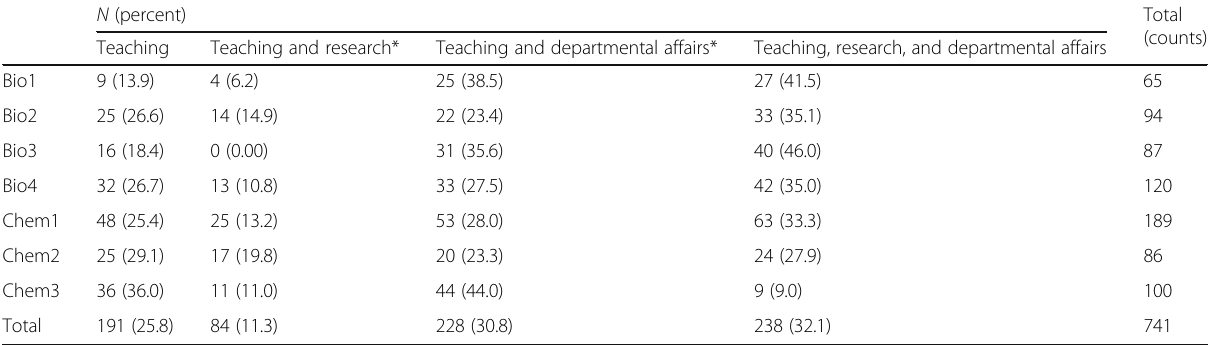
Table 3 Count and percent of multiplex teaching ties N (percent)